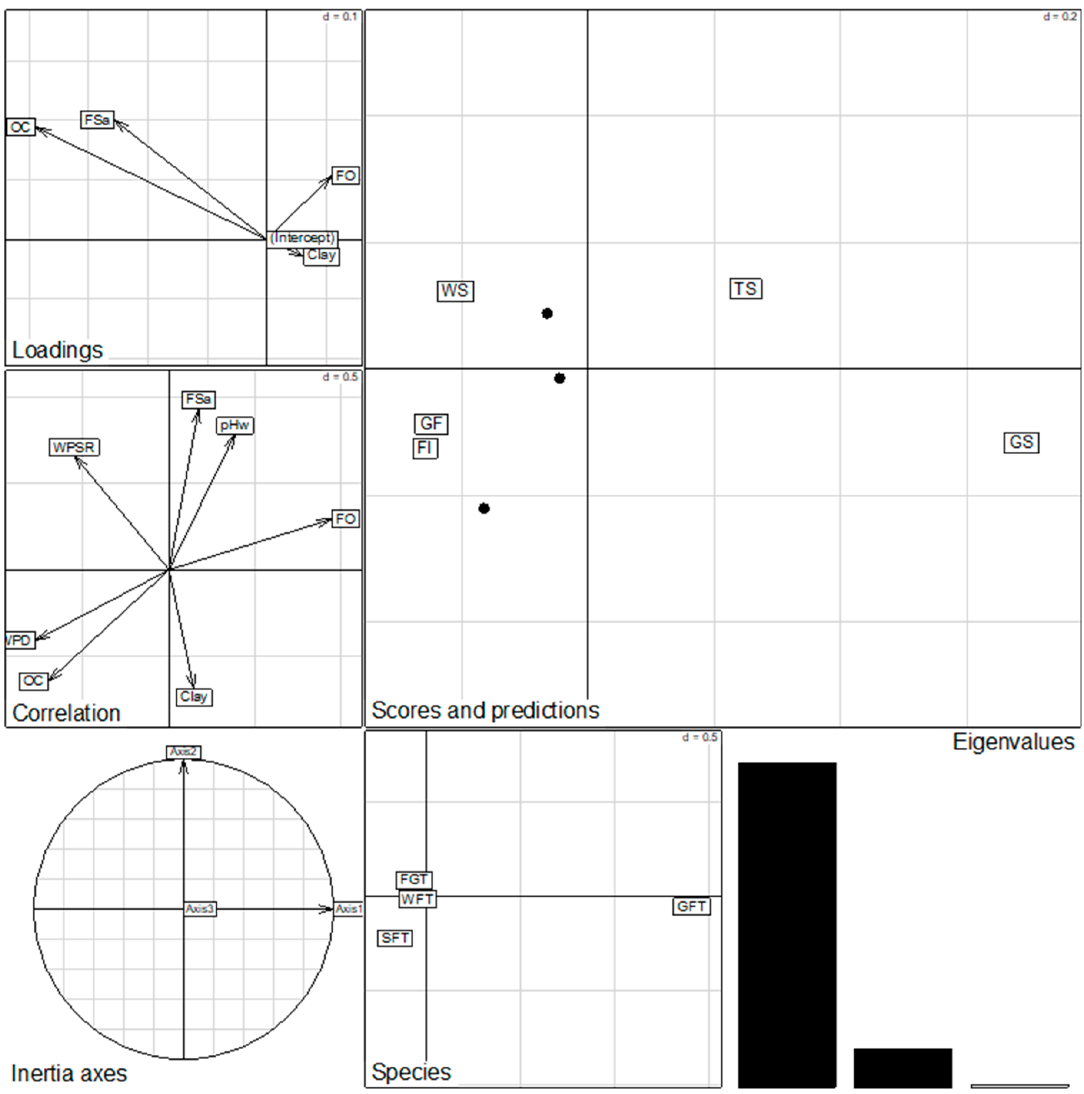
Figure 4. Diagram of CCA ordination of habitat-specific abundance of collected termite’s feeding groups in dependence of environmental variables.